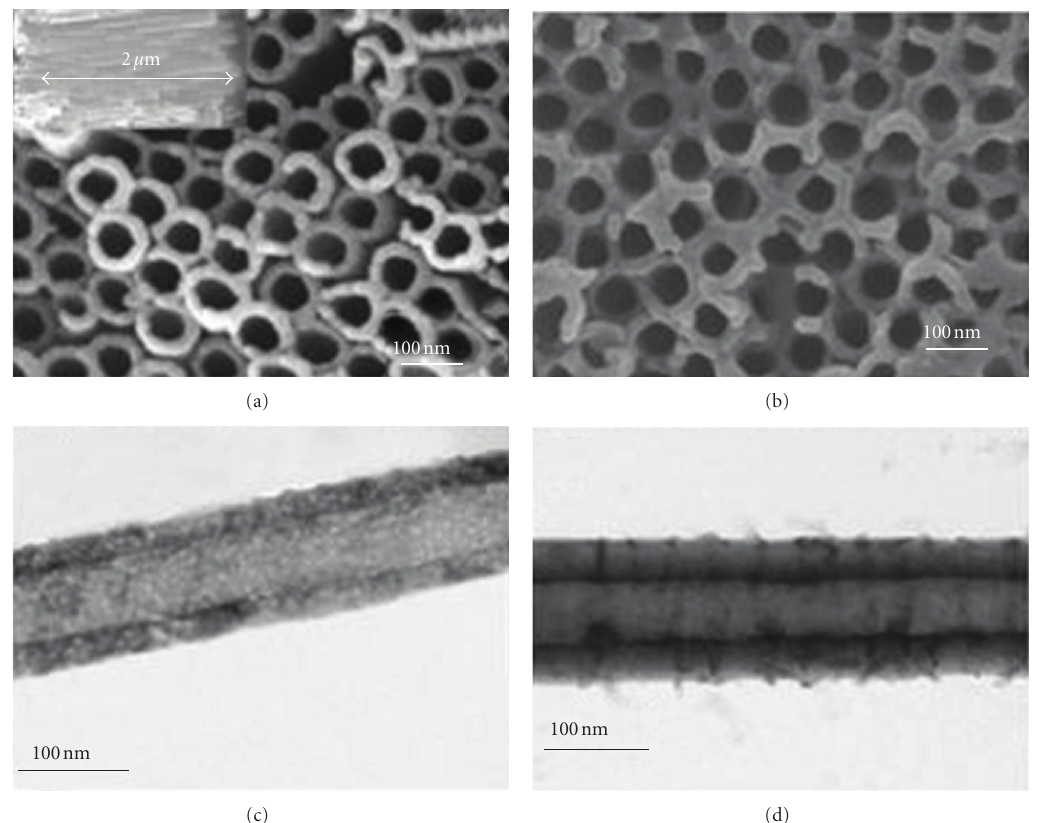
Figure 6: SEM (a, b) and TEM (c, d) images of self-organized TiO 2 NTs (a, c) and BiOI/TiO 2 NTs (b, d). (a) Top and side (inset) view SEM images of the unmodified TiO 2 NTs. (b) Top SEM image of BiOI/TiO 2 NTs. (c) TEM images of the unmodified TiO 2 NTs. (d) TEM images of BiOI/TiO 2 NTs